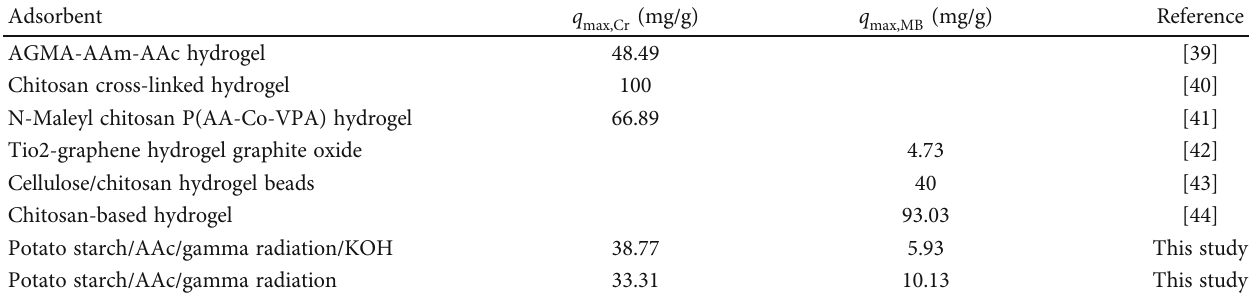
Table 3: Adsorption capacity of hydrogels for Cr and MB dye removal.